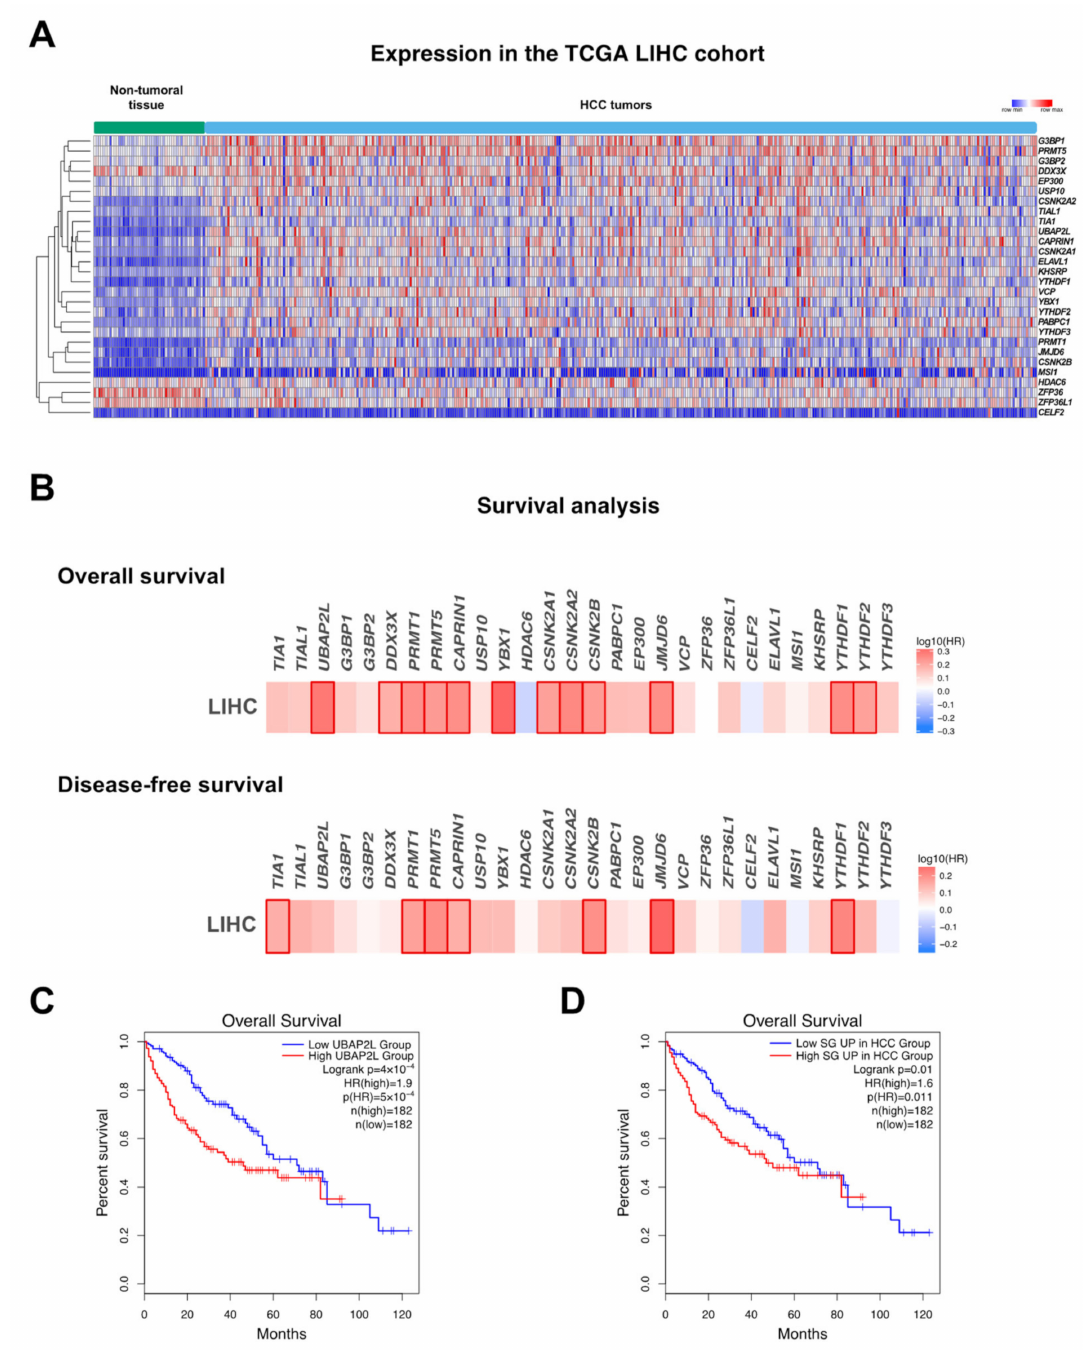
Figure 3. SG assembly in hepatocellular carcinoma. ( A ) mRNA expression levels of genes associated with stress granules in the LIHC TCGA cohort. ( B ) Heat map showing hazard ratio (HR) for overall and disease-free survival based on the expression of genes associated with stress granules in the LIHC TCGA cohort (http://gepia.cancer-pku.cn/, accessed on 1 April 2021). Positive hazard ratio indicates lower possibility of survival. Frames indicate significance. ( C ) Survival curve showing overall survival of patients expressing high vs. low levels of UBAP2L. ( D ) Survival curve showing overall survival of patients expressing high vs. low levels of SG-associated genes that are significantly upregulated in the LIHC TCGA